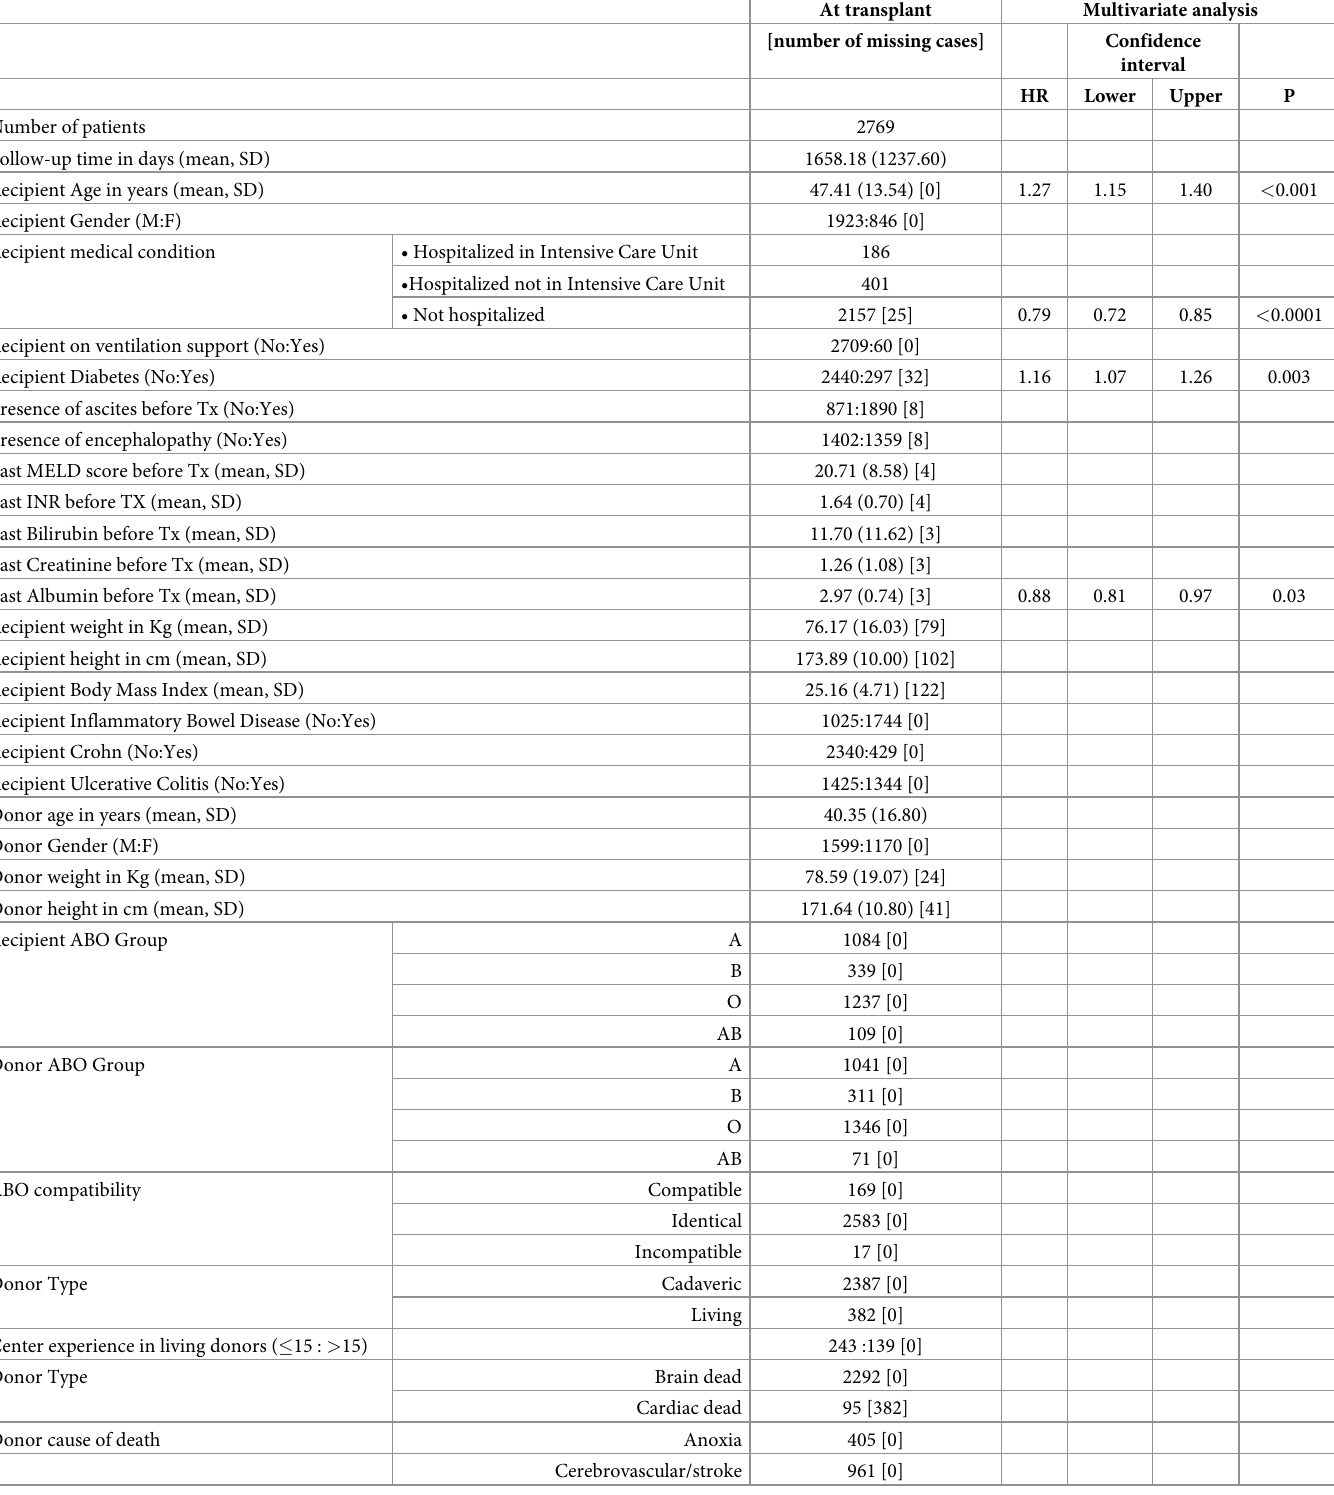
Table 1. Demographics of the included